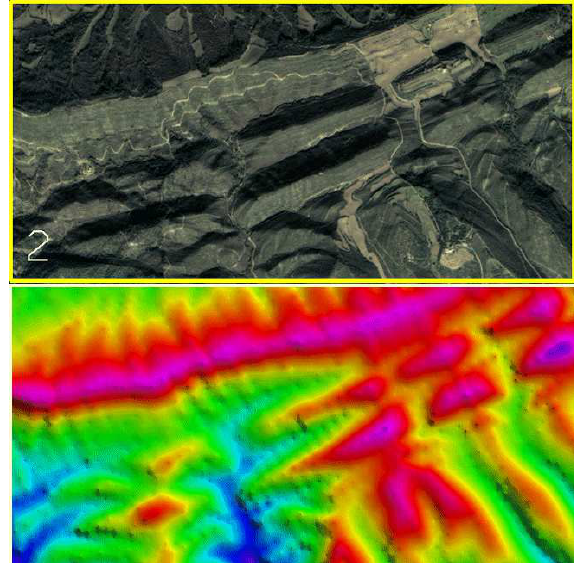
Figure 3. Above: test area 2, 4km x 2km, max. elevation difference dh: 250m. Below: Colour coded representation of the DSM.